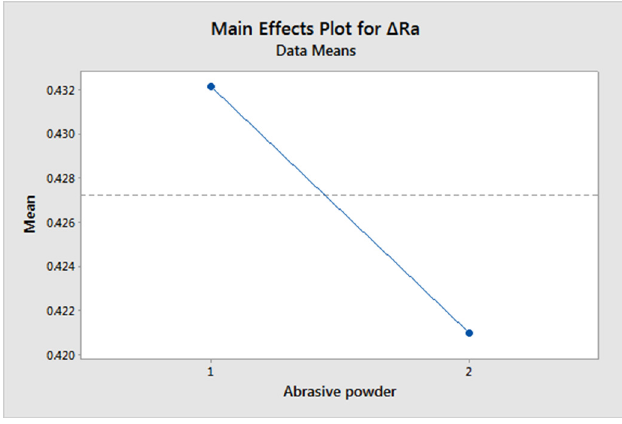
Fig. 9. The effect of abrasive powder on D R a (1 =Al 2 O 3 , 2= TiO 2